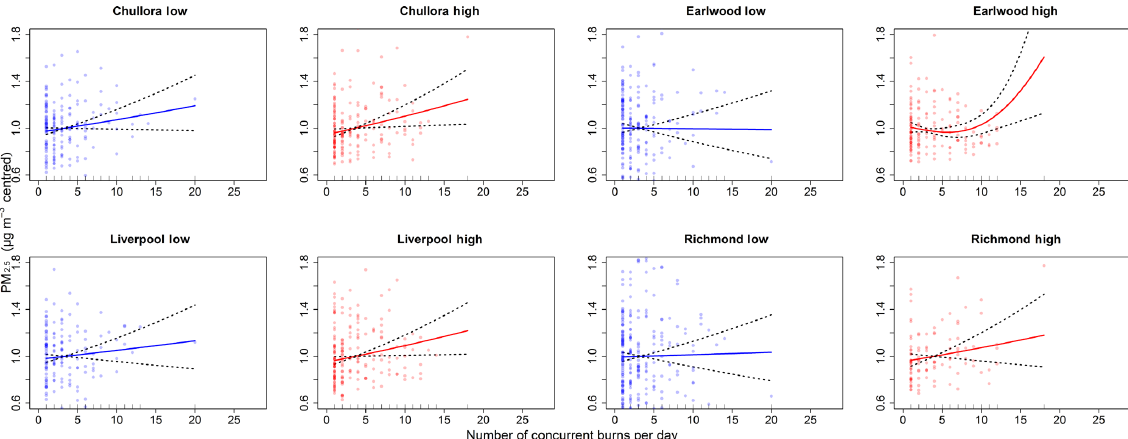
Figure 10. The contribution by the hazard reduction burn (HRB) daily frequency (number of concurrent burns per day) component of the GAMM linear predictor to fitted PM 2 . 5 values (µgm − 3 , centred).